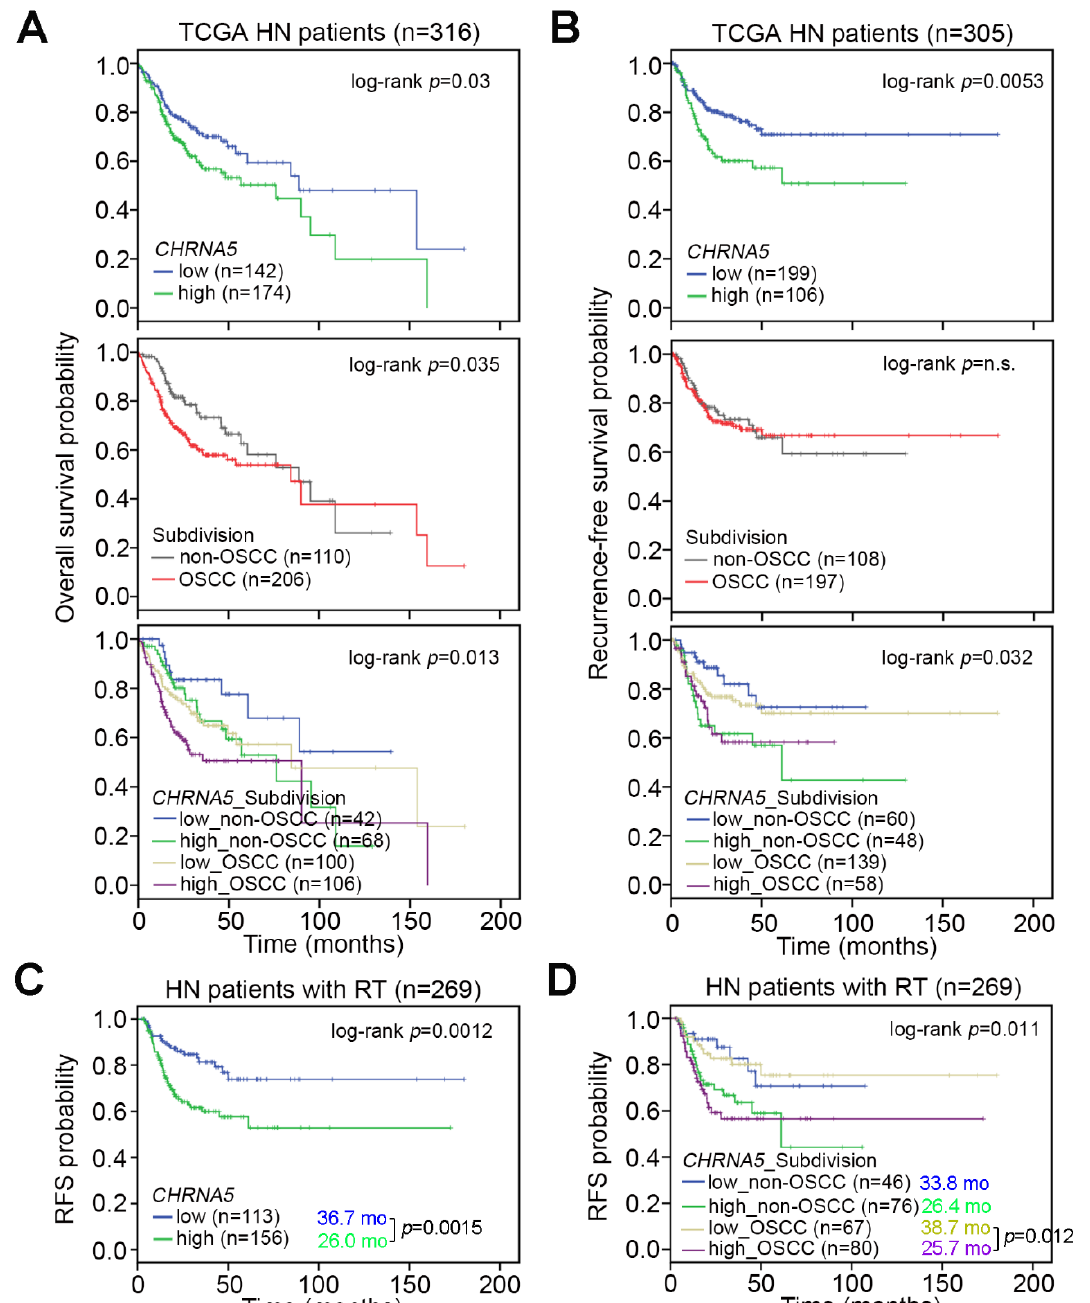
Figure 2: CHRNA5 serves as a marker of poor prognosis in OSCC patients. ( A ) Kaplan – Meier analysis of overall survival probability for patients with head and neck cancer in TCGA database, with respect to CHRNA5 expression (top), Head and Neck Squamous Cell Carcinoma (HNSCC) subdivision (middle,) and CHRNA5 expression combined with HNSCC subdivision (bottom). ( B ) Kaplan – Meier analysis of recurrence-free survival probability for patients with head and neck cancer in TCGA database, with respect to CHRNA5 expression (top), HNSCC subdivision (middle), and CHRNA5 expression combined with HNSCC subdivision (bottom). (C and D) Kaplan – Meier analysis of recurrence-free survival (RFS) probability for HNSCC patients treated with radiotherapy, with respect to CHRNA5 mRNA levels ( C ) and the combined signature of CHRNA5 mRNA levels with HNSCC subdivision ( D ). In C and D, the statistical difference in the average survival time was analyzed by Student’s t- test.